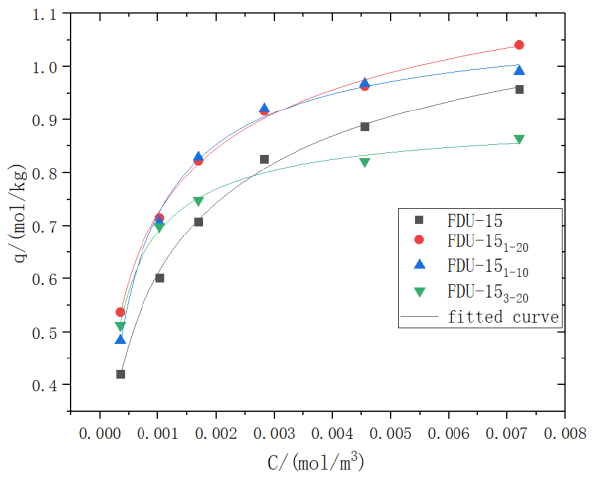
Figure 4. Adsorption isotherms of Nap on FDU-15 and modified FDU-15.